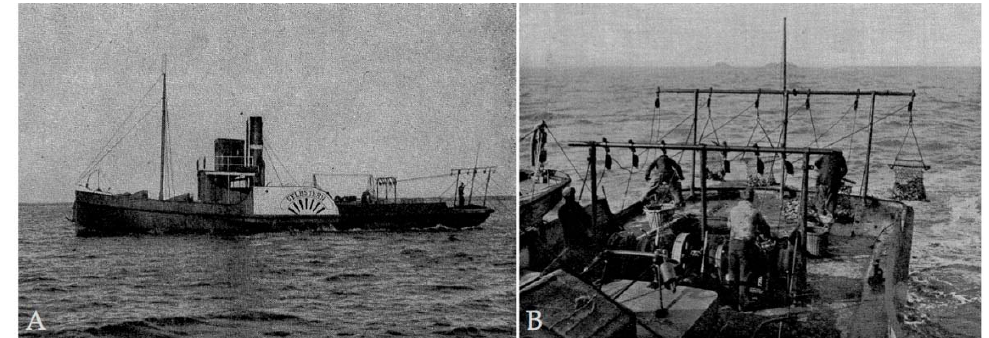
Figure 3. Oyster trawler Gelbstern ( A ) and oyster dredges ( B ). Modified after Hagmeier and Kändler (1927). Neue Untersuchungen im nordfriesischen Wattenmeer und auf den fiskalischen Austernbänken. Aus der Biologischen Anstalt auf Helgoland und deren Zweiglaboratorium in List a. Sylt 16(6): 1–90.